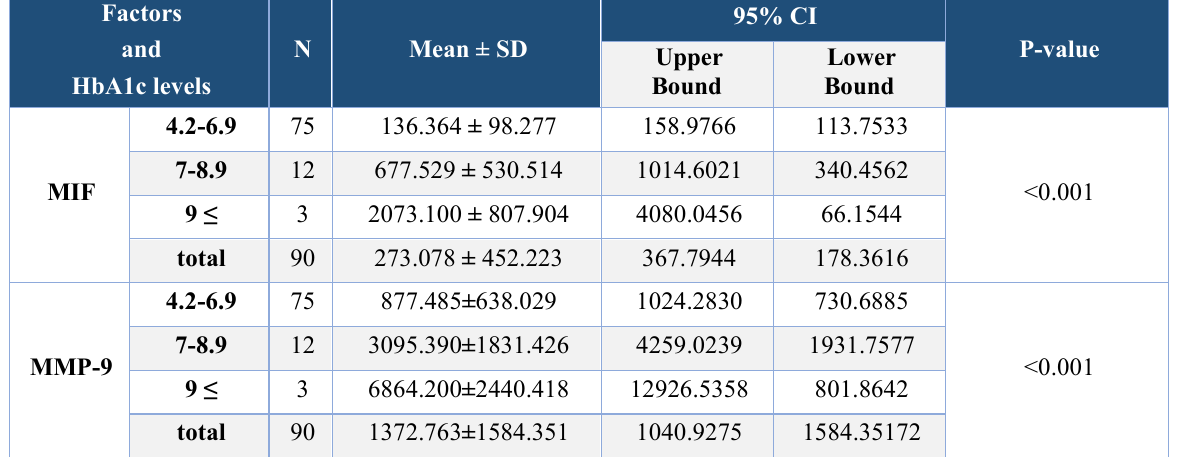
Table 3. Comparison between the factor levels and the different levels of HbA1c Factors